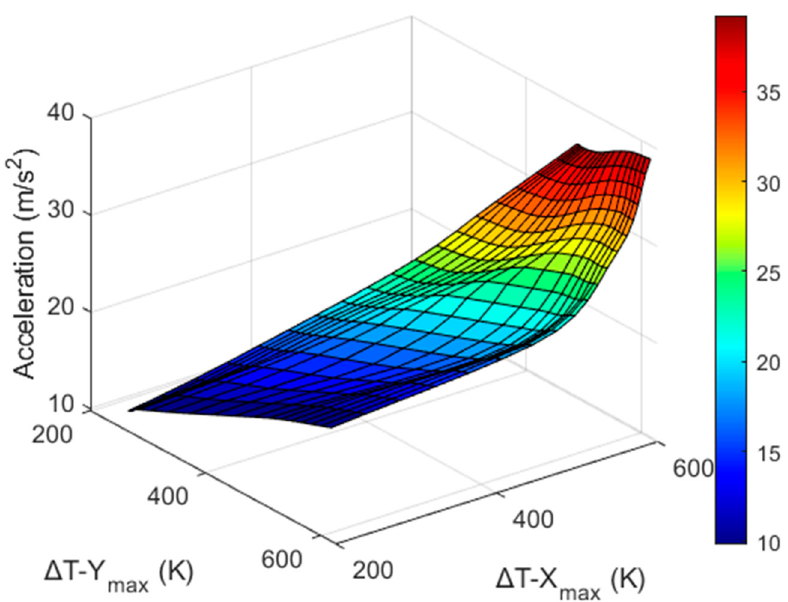
Figure 18. Graph to obtain a from Δ T y and Δ T x data measured around heater 3 (isometric drawing).